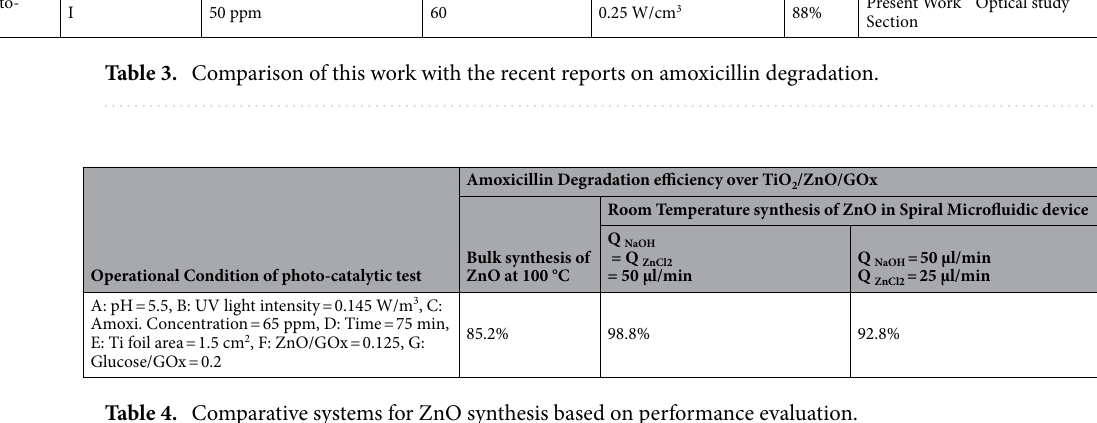
Table 4. Comparative systems for ZnO synthesis based on performance